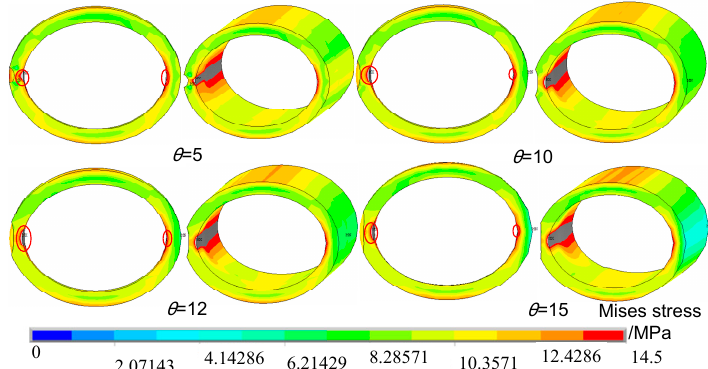
Figure 22. Critical failure load of HDPE pipe with various defect widths. Figure 23 shows the distribution of pipeline failure position with defect width. The pipeline failure positions are located on the inner wall of the arch camber line on both sides of the pipe. As the defect width increased, the failure area on the inner wall of the pipeline at the defect position gradually increased.